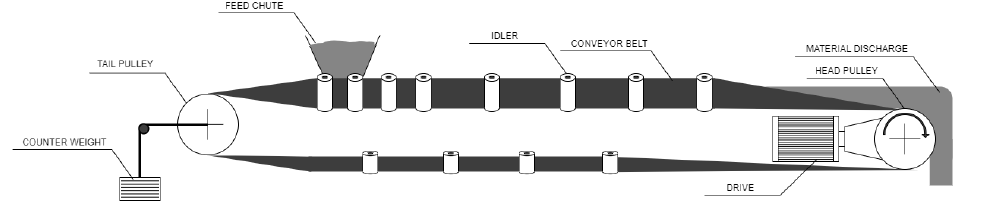
Figure 1. Diagram of the